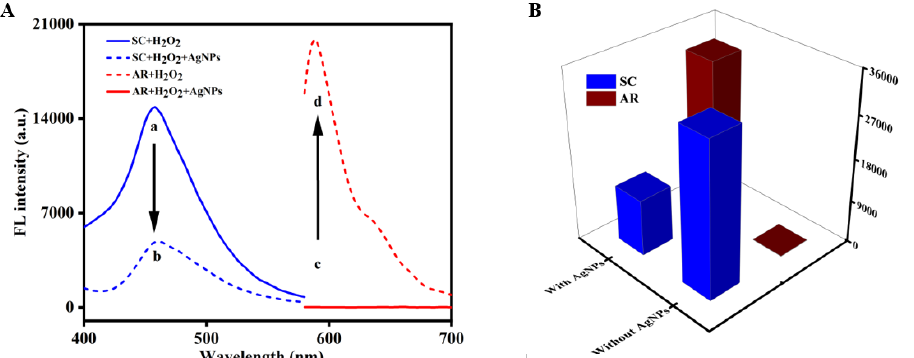
Figure 2. ( A ) Fluorescence spectra of separately used SC in (a) the absence of AgNPs, (b) the presence of AgNPs, and (c,d) separately used AR. ( B ) 3D fluorescent columns of simultaneously used SC (blue columns) and AR (red columns) without and with AgNPs.